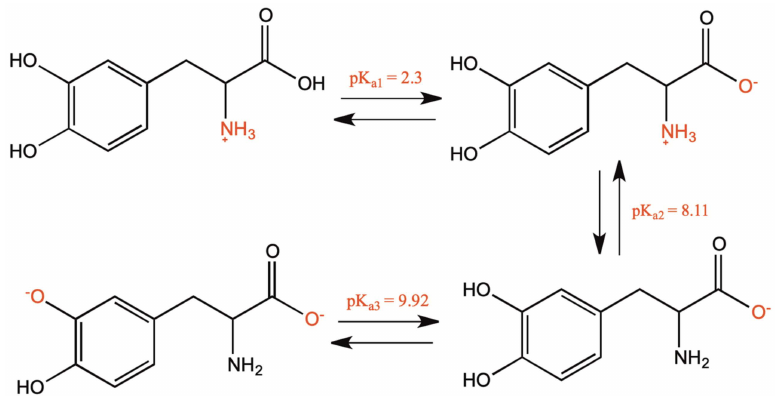
Figure 2. Ionization of L-Dopa at various pH values.